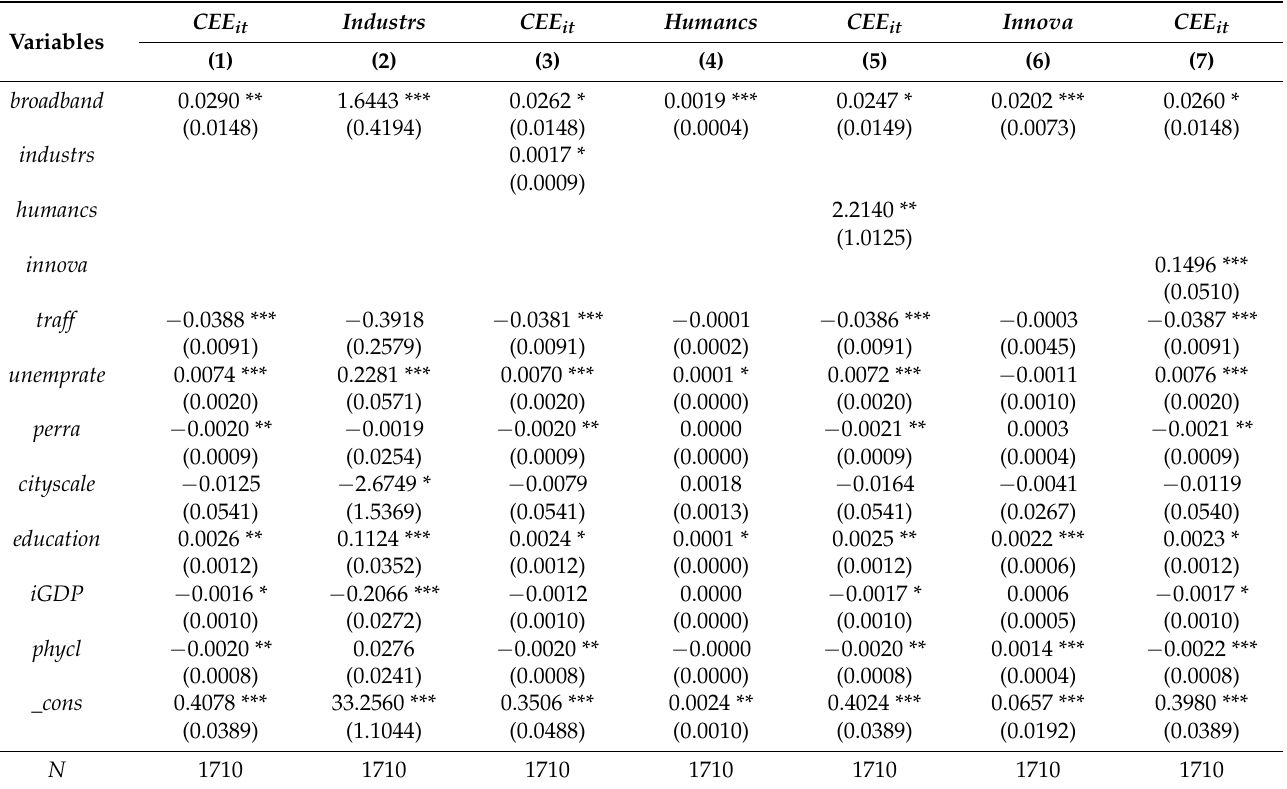
Table 8. Mechanism regression